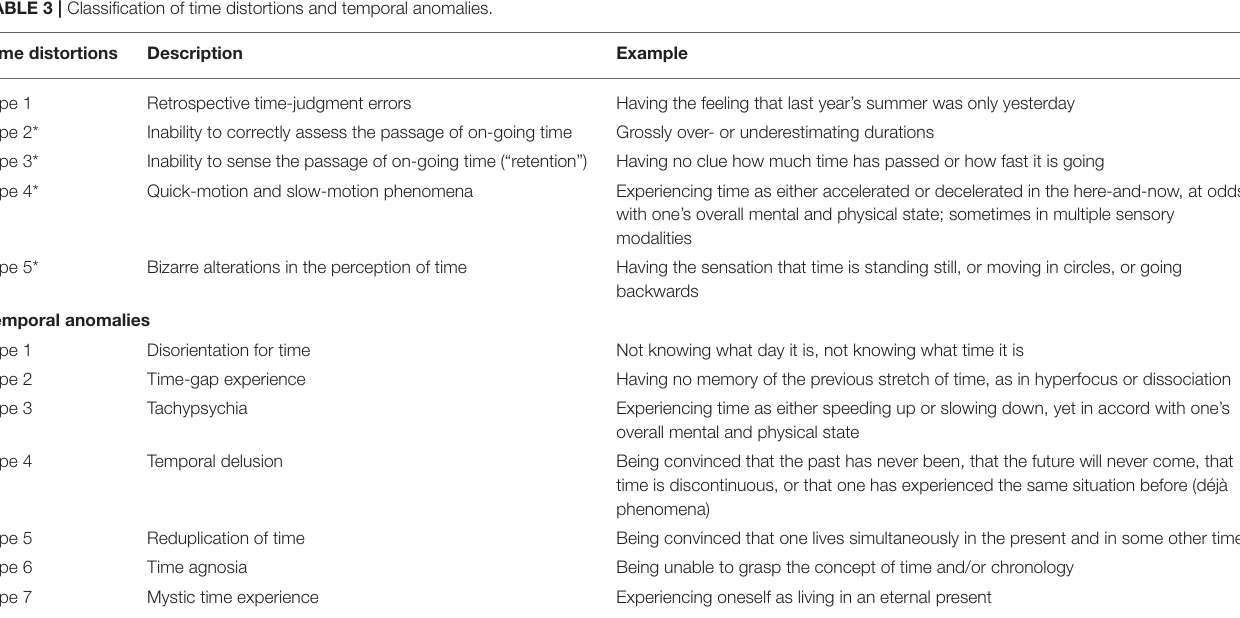
TABLE 3 | Classification of time distortions and temporal